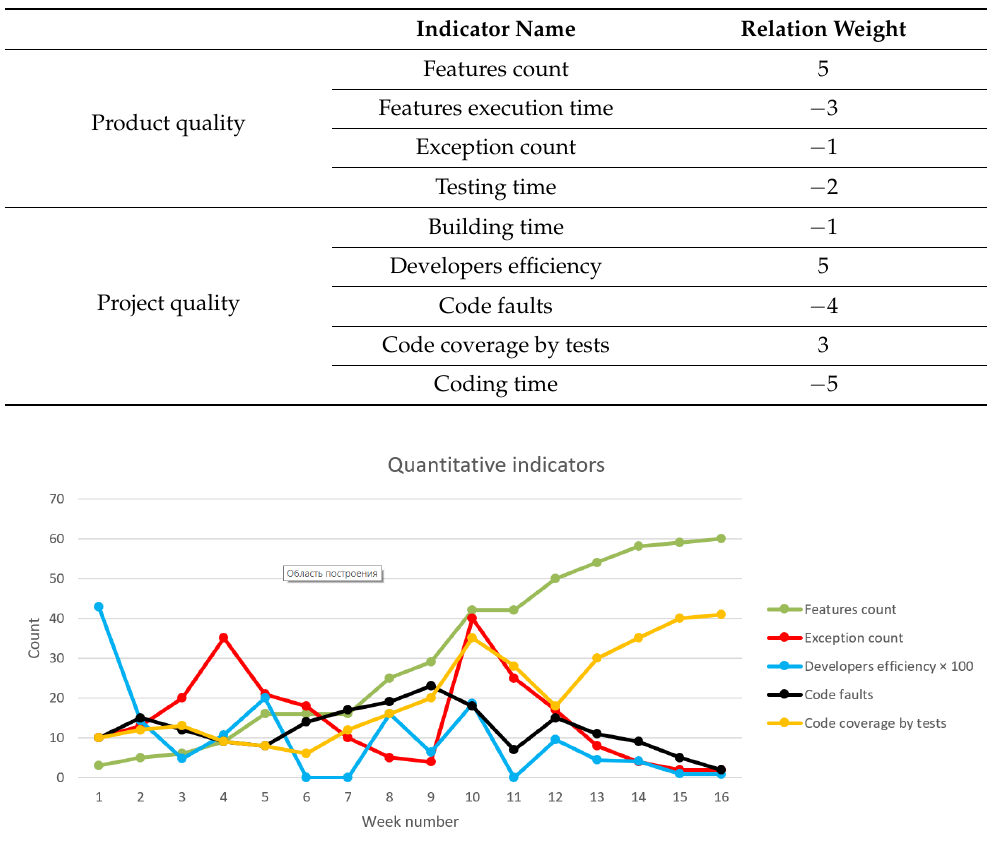
Figure 4. Time series of quantitative indicators.